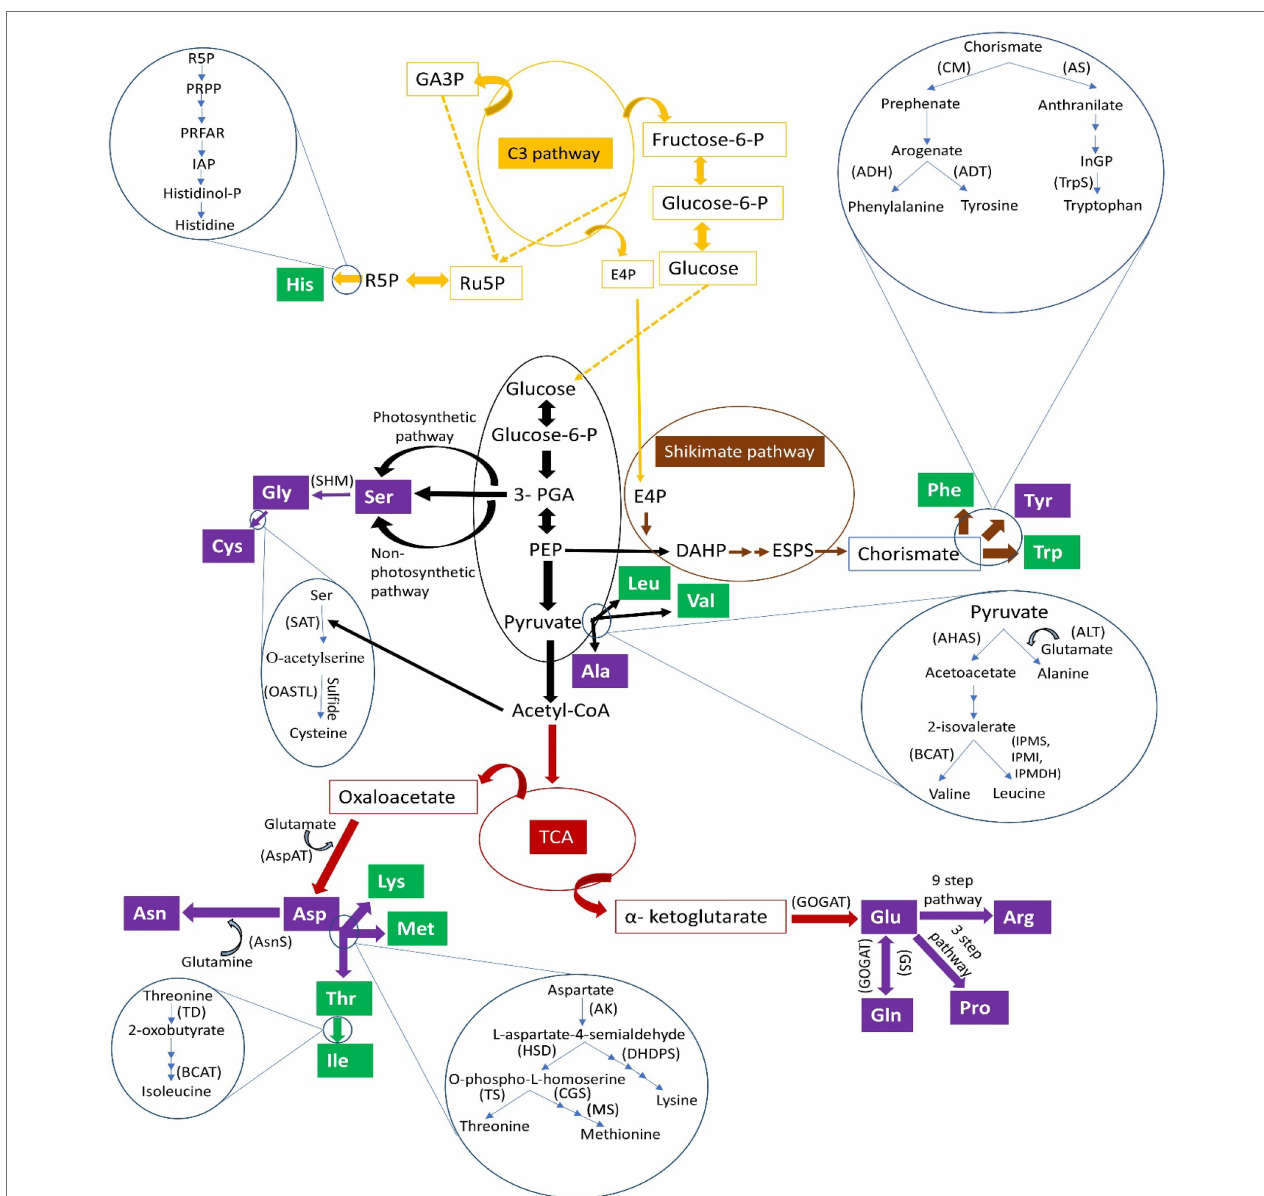
FIGURE 1 | Pathways synthesizing various essential (green boxes) and non-essential (purple boxes) amino acids. Amino acids: Ala, alanine; Arg, arginine; Asn, asparagine; Asp, aspartate/aspartic acid; Cys, cysteine; Gln, glutamine; Glu, glutamate/glutamic acid; Gly, glycine; His, histidine; Ile, isoleucine; Leu, leucine; Lys, lysine; Met, methionine; Phe, phenylalanine; Pro, proline; Ser, serine; Thr, threonine; Trp, tryptophan; Tyr, tyrosine; Val, valine). Substrates/precursors: acetyl-CoA, acetyl-coenzyme A; DAHP, 3-deoxy-D-arabinoheptulosonate-7-phosphate; ESPS, 5-enolpyruvylshikimate-3-phosphate; E4P, erythrose 4-phosphate; fructose-6-P, fructose-6-phosphate; GA3P, glyceraldehyde 3-phosphate; glucose-6-P, glucose-6-phosphate; histidinol-P, histidinol phosphate; IAP, imidazole acetol-phosphate; PEP, phosphoenol pyruvate; 3-PGA, 3-phosphoglyceric acid; PRFAR, ( N´ -[(5 ′ -phosphoribulosyl)formimino]-5-aminoimidazole-4-carboxamide) ribonucleotide); PRPP, phosphoribosyl diphosphate; R5P, ribose 5-phosphate; Ru5P, ribulose 5-phosphate. Enzymes indicated in parentheses: ADH, arogenate dehydrogenase; ADT, arogenate dehydratase; AHAS, acetohydroxyacid synthase; AK, aspartate kinase; ALT, alanine transferase; AS, anthranilate synthase; AsnS, asparagine synthetase; AspAT, aspartate aminotransferase; BCAT, branched-chain amino acid aminotransferase; CGS, cystathionine gamma synthase; CM, chorismate mutase; DHDPS, dihydrodipicolinate synthase; GOGAT, glutamate synthase; GS, glutamine synthetase; HSD, homoserine dehydrogenase; IPMS, isopropylmalate synthase; MS, methionine synthase; OASTL, O-acetylserine(thiol)lyase; SAT, serine acetyltransferase; SHM, serine hydroxymethyltransferase; TD, threonine deaminase; TrpS, tryptophan synthase; TS, threonine